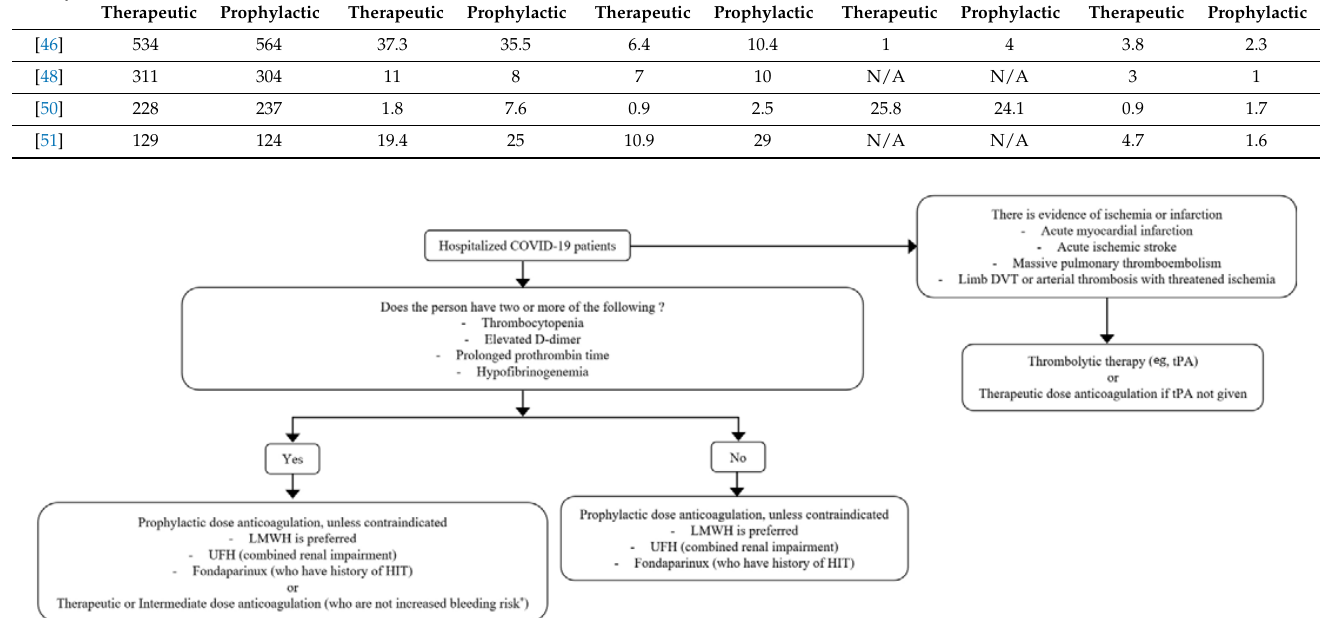
Figure 2. Anticoagulation therapy in hospitalized patients wCOVID-19 Abbreviations: LMWH, low- molecular-weight heparin; UFH, unfractionated heparin; HIT, heparin-induced thrombocytopenia; DVT, deep vein thrombosis; tPA, tissue plasminogen activator.* Contraindications for the use of therapeutic anticoagulants: platelet count < 50 × 10 9 /L, hemoglobin (Hgb) < 8 g/dL, the need for dual antiplatelet therapy, bleeding within the last 30 days that required an emergency department visit or hospitalization, and a history of